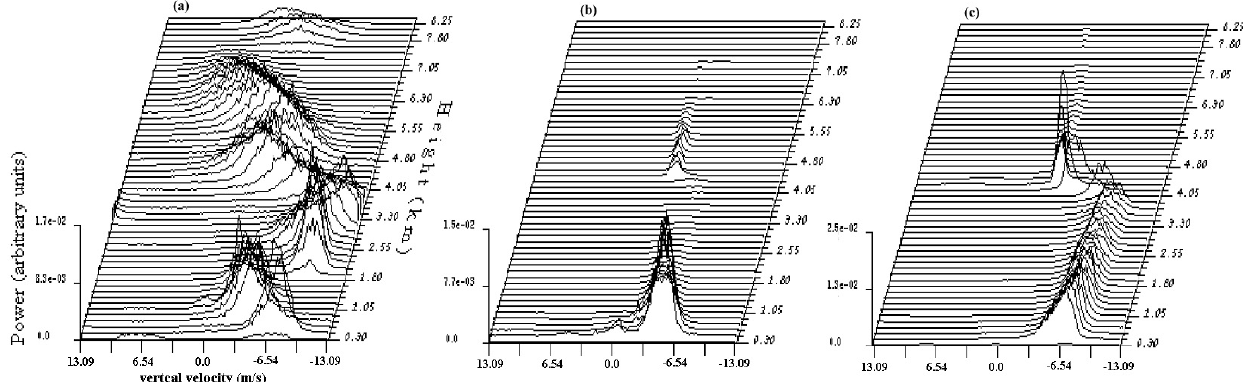
Fig. 12. Typical UHF radar power spectra observed in (a) convective, (b) intermediary and (c) stratiform regions of a mesoscale convective system (21 June